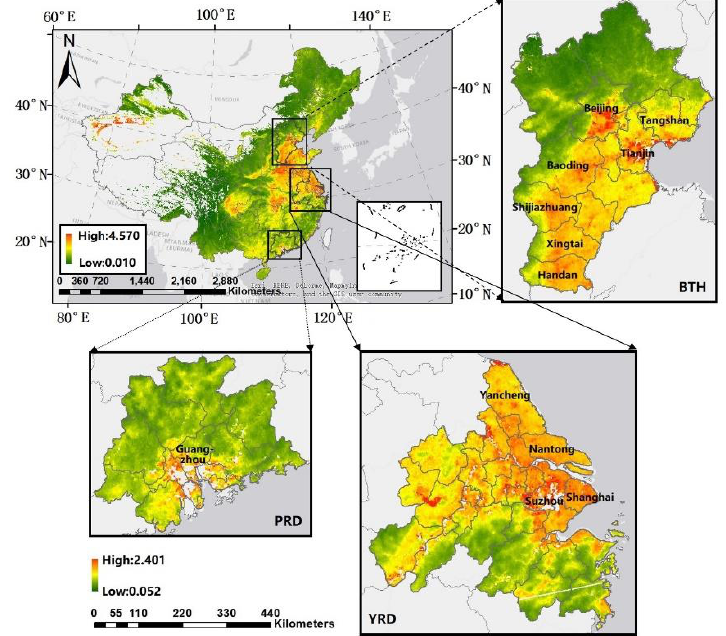
Figure 1. The locations of study areas in China and the corresponding spatial distributions of aerosol optical depth (AOD).